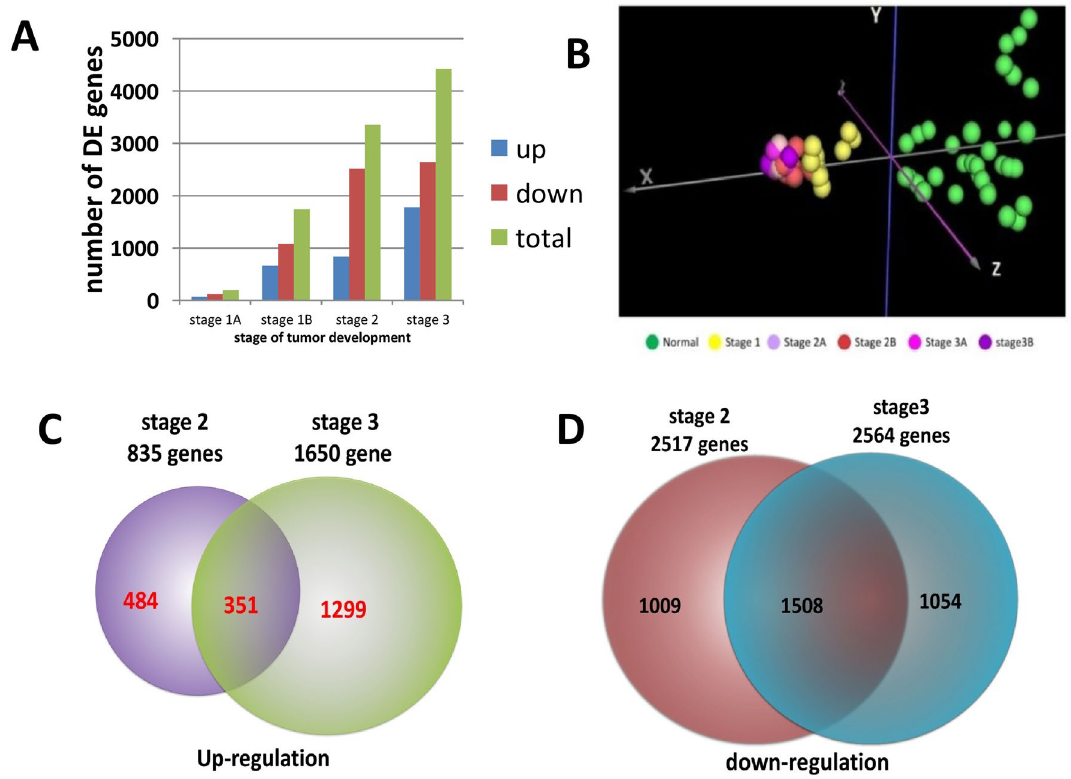
Figure 1. The results from gene differential expression analysis and classification of tumor stages of NSCLC patients using principle component analysis (PCA). ( A ) Number of genes differentially expressed between cancer and normal samples. Cancer and normal samples were taken from patients at stages 1–3 in Taiwan female lung cancer cohort. ( B ) PCA was used to classify tumor stages of cancer patients based on differential expression of 26 TS genes. Coordinate x is the first component, coordinates y and z are respectively the second and third components. ( C ) Numbers of up-regulated genes detected at stages 2 and 3 and of the common up-regulated genes between both stages. ( D ) Numbers of down-regulated genes detected at stages 2 and 3 and of the common down-regulated genes between both